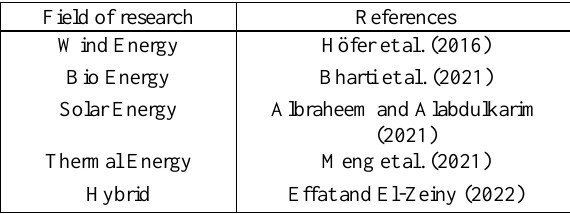
Table 1 . Application of AHP method in previous